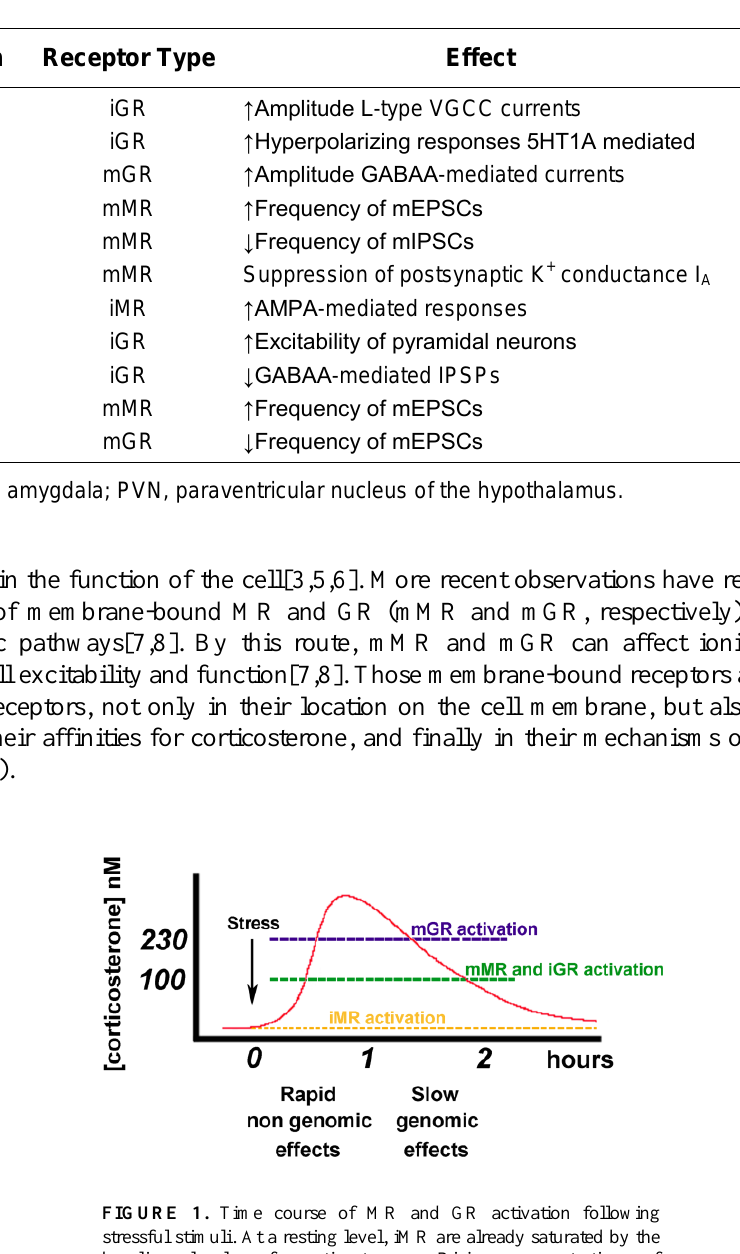
Main Effects of Corticosteroids on Cellular Physiology of Limbic Cells